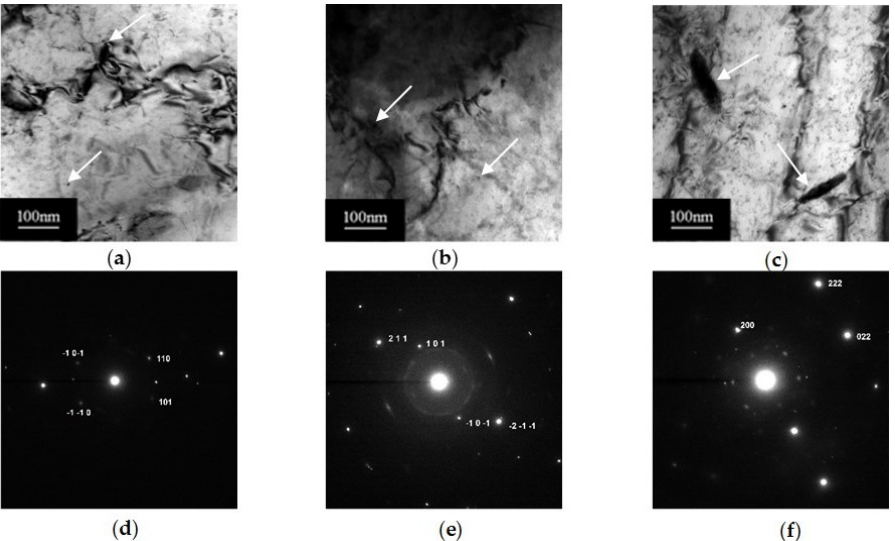
precipitates close to the grain boundaries, ( a ) bright field image of steel rolled at RT = 790 °C, ( b ) bright field image of steel rolled at RT = 830 °C, ( c ) bright field image of steel rolled at RT = 870 °C, ( d ) dark field image of steel rolled at RT = 790 °C, ( e ) dark field image of steel rolled at RT = 830 °C, ( f ) dark field image of steel rolled at RT = 870 °C. The precipitates are indicated by arrows.